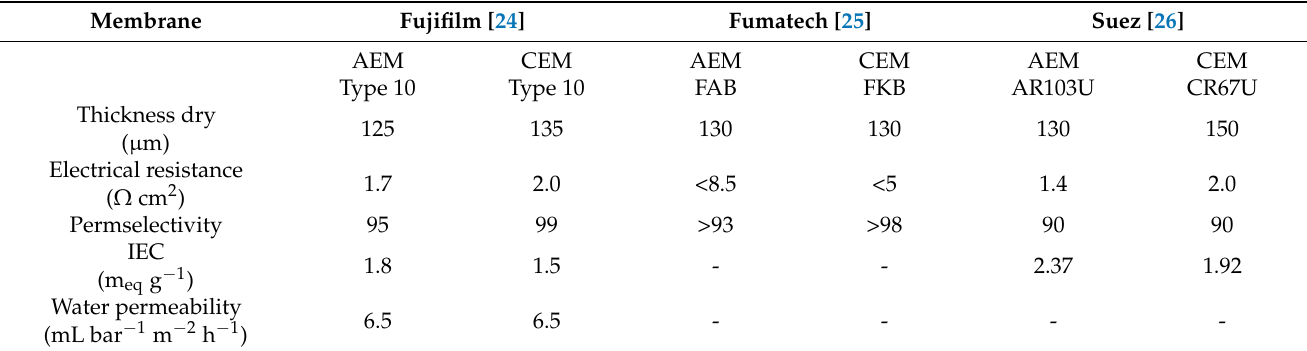
Table 1. Properties of the ion exchange membranes (IEMs) used in this